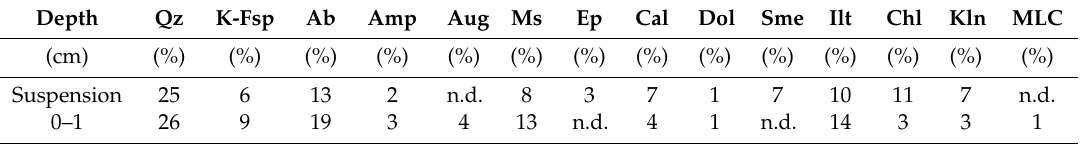
Table 5. Mineral composition (XRD) of the near-bottom suspended particle (Suspension) and uppermost sediment layer (0–1 cm) of the core AMK-5432 (the Bear Island